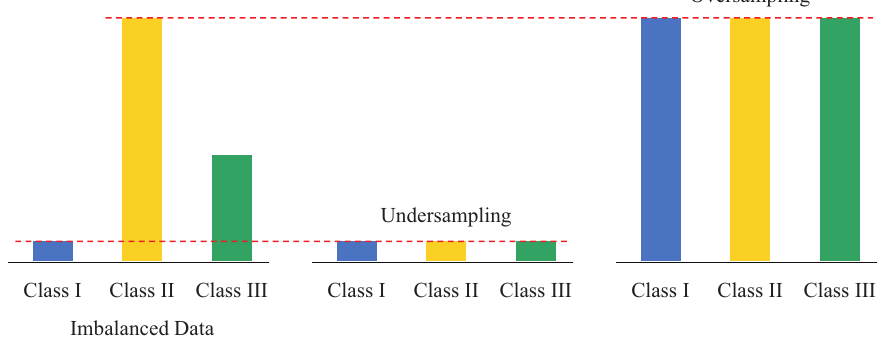
Figure 2. Change of the number of datasets according to sampling technique. Here, the underweight, normal weight and overweight classes are denoted as Classes I, II and III,